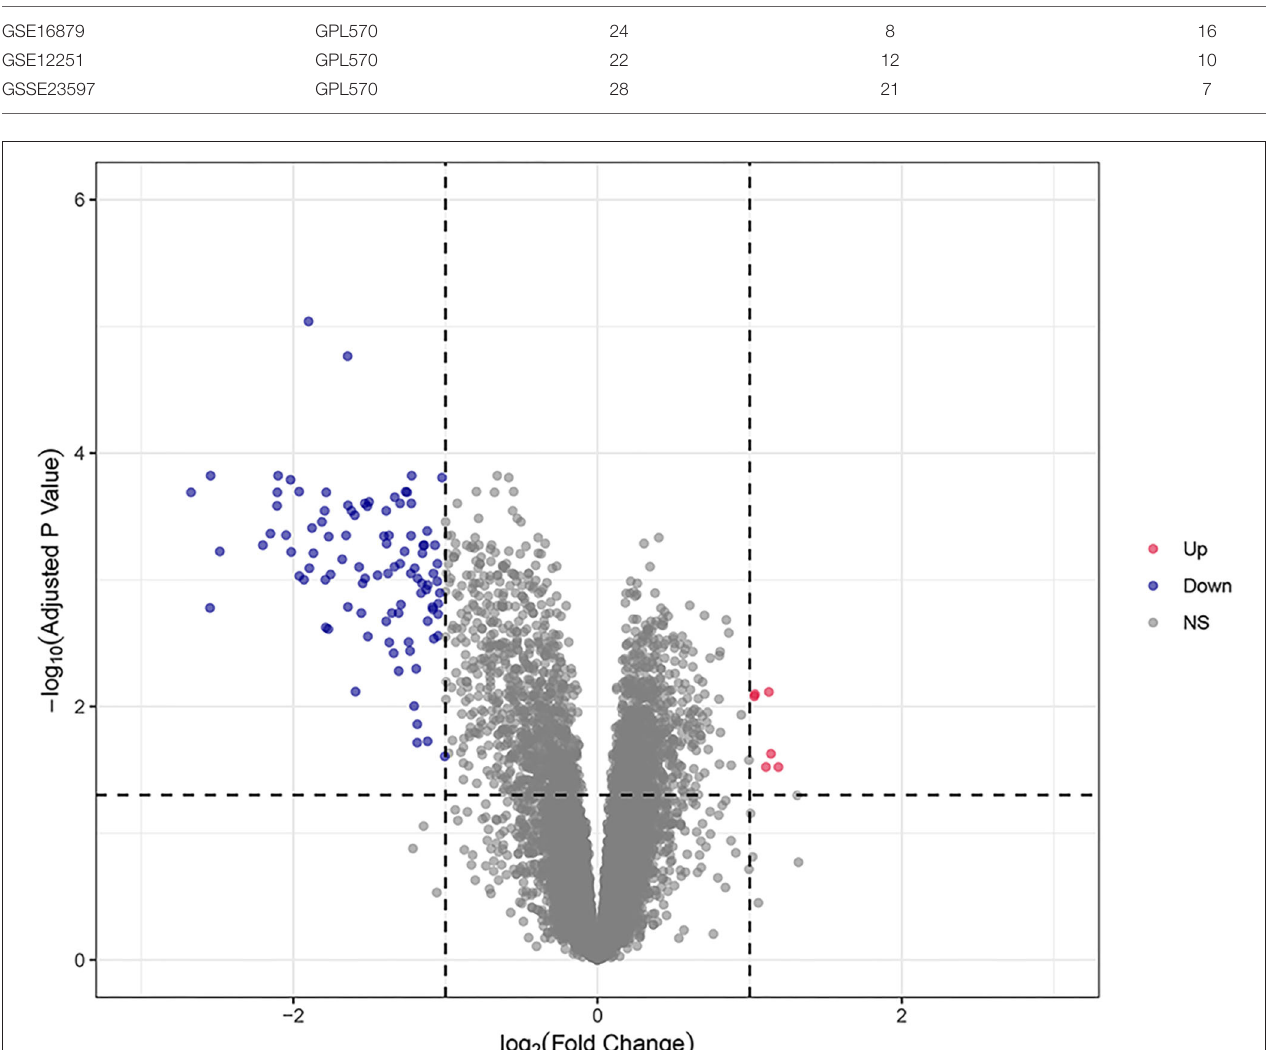
FIGURE 2 | The volcano plots of all DEGs in the training dataset. Blue and red spots represent downregulated and upregulated genes, respectively. A clear demarcation can be identified between upregulated genes and downregulated